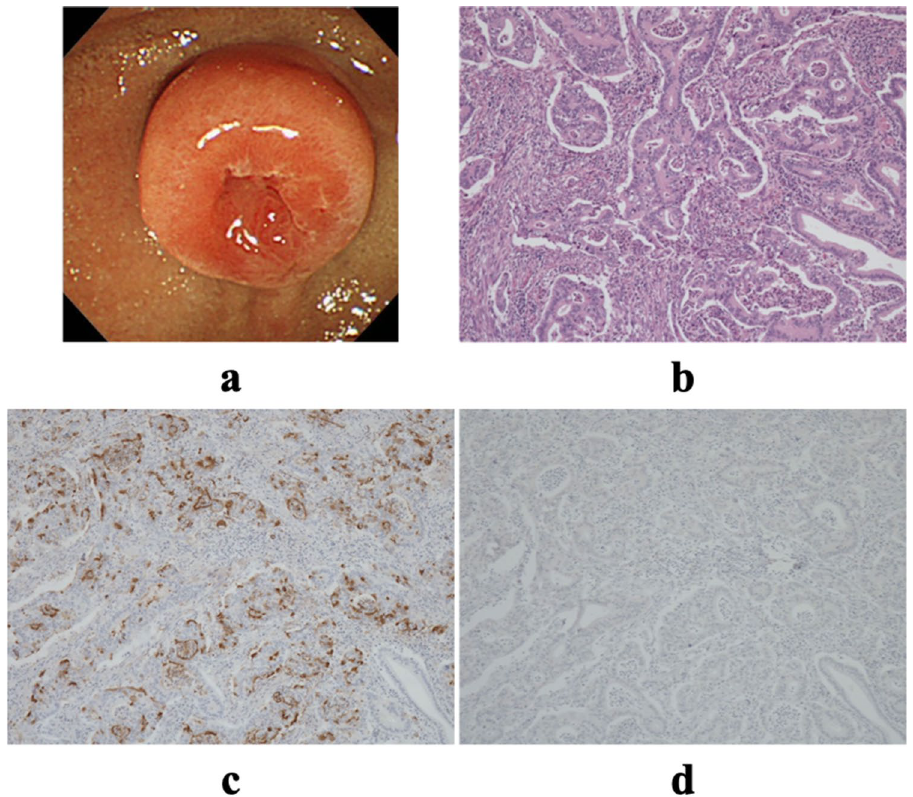
Figure 4. Characteristics of pancreatobiliary-type tumors. ( a ) Endoscopic image. ( b ) Hematoxylin–eosin staining of the tumor (× 40). ( c ) MUC1 expression in the tumor (× 40). ( d ) MUC2 expression in the tumor (× 40). MUC1, pancreatic-type mucin; MUC2, intestinal-type